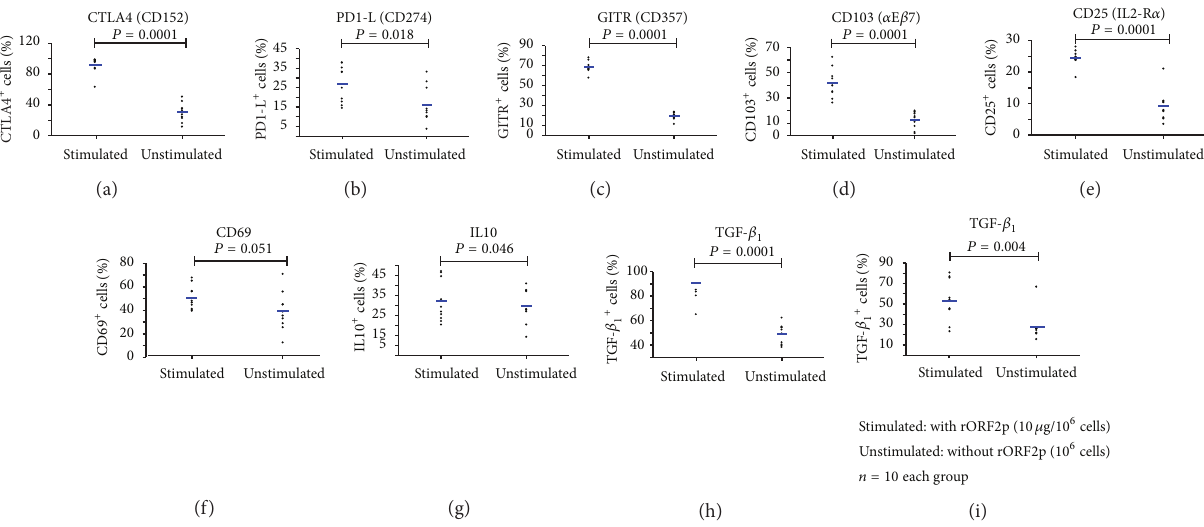
Figure 2: HEV rORF2p stimulated peripheral expression profiles in hepatitis E patients by flow cytometry. HEV rORF2p stimulated expression of inhibitory (CTLA-4, PD1L, and GITR), integrin (CD103), activation (CD25, CD69), and Treg-associated cytokines (IL10, TGF- 𝛽 1 )onPBMCsofAVH-E(a–h)andrecovered(i); n =numbersofpatients.Eachdotrepresentsanindividualdatapointandthehorizontallines represent the mean. The ANOVA with Bonferroni post hoc corrections was used to compare differences among groups. Data are representative of mean ± SD.